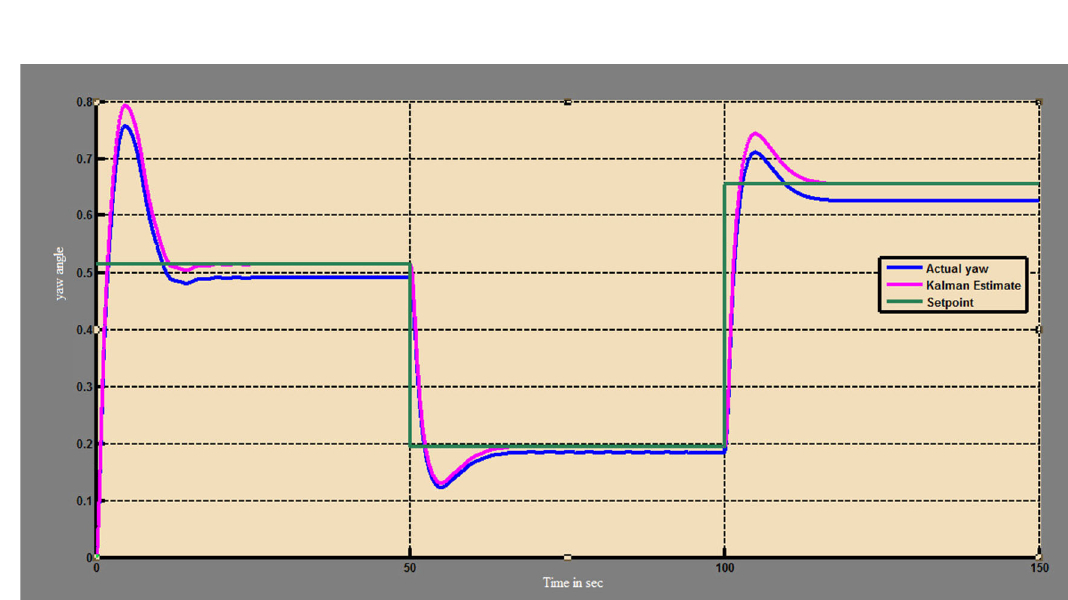
Figure 14. Estimation of yaw with Kalman